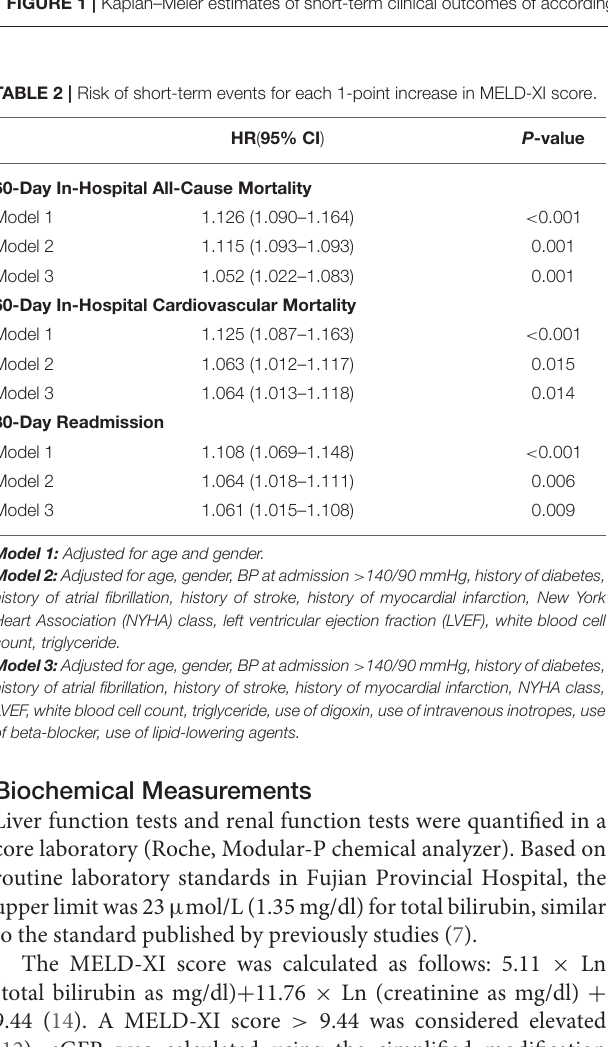
FIGURE 1 | Kaplan–Meier estimates of short-term clinical outcomes of according to baseline MELD-XI score.